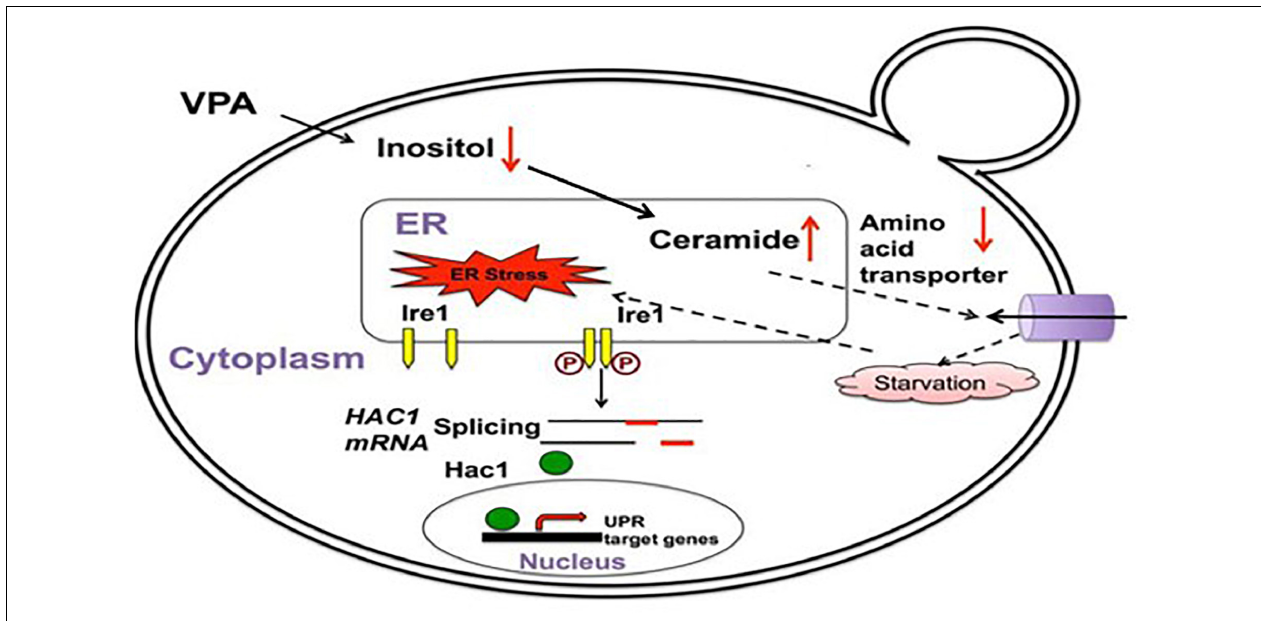
FIGURE 2 | VPA induces the UPR pathway in yeast by increasing intracellular ceramide levels. VPA-mediated myo -inositol depletion results in elevated ceramide levels. Elevated ceramide results in the downregulation of amino acid transporters and subsequent UPR activation due to starvation stress. Figure adapted and modified from Jadhav et al.